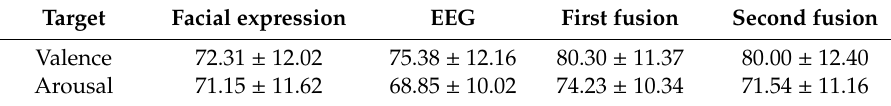
Table 2. Emotion recognition accuracy for the DEAP data set.